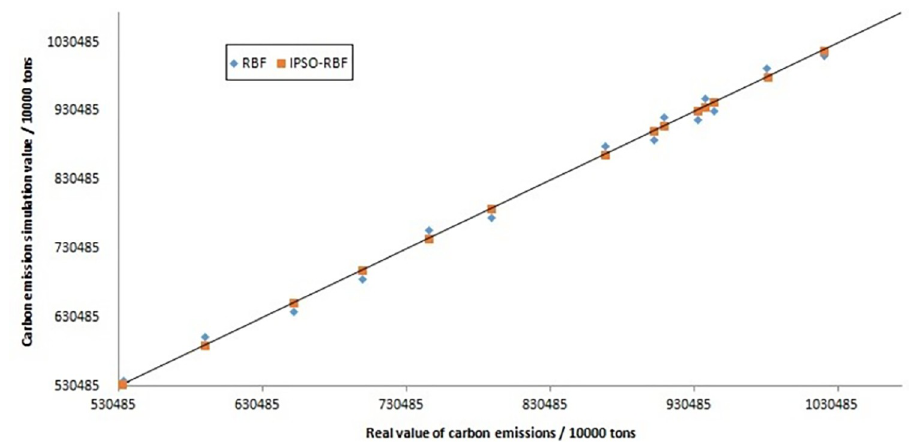
Fig 9. Comparison of simulation results between IPSO-RBF model and RBF neural